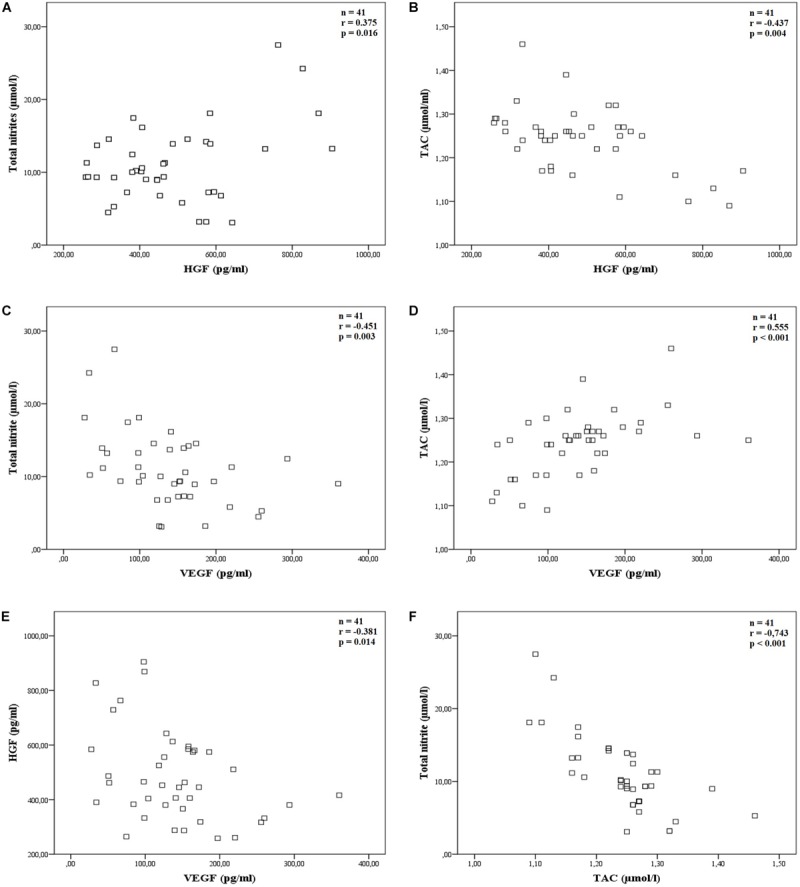
Correlations of the main studied parameters. The scatter plot showing Pearson’s or Spearman’s correlation between: (A) total nitrite and HGF, r = 0.375, p = 0.016 (n = 41); (B) TAC and HGF, r = −0.437, p = 0.004 (n = 41); (C) total nitrite and VEGF, r = −0.451, p = 0.003 (n = 41); (D) TAC and VEGF, r = 0.555, p < 0.001 (n = 41); (E) HGF and VEGF, r = −0.381, p = 0.014 (n = 41) and (F) total nitrite and TAC, r = −0.743, p < 0.001 (n = 41).